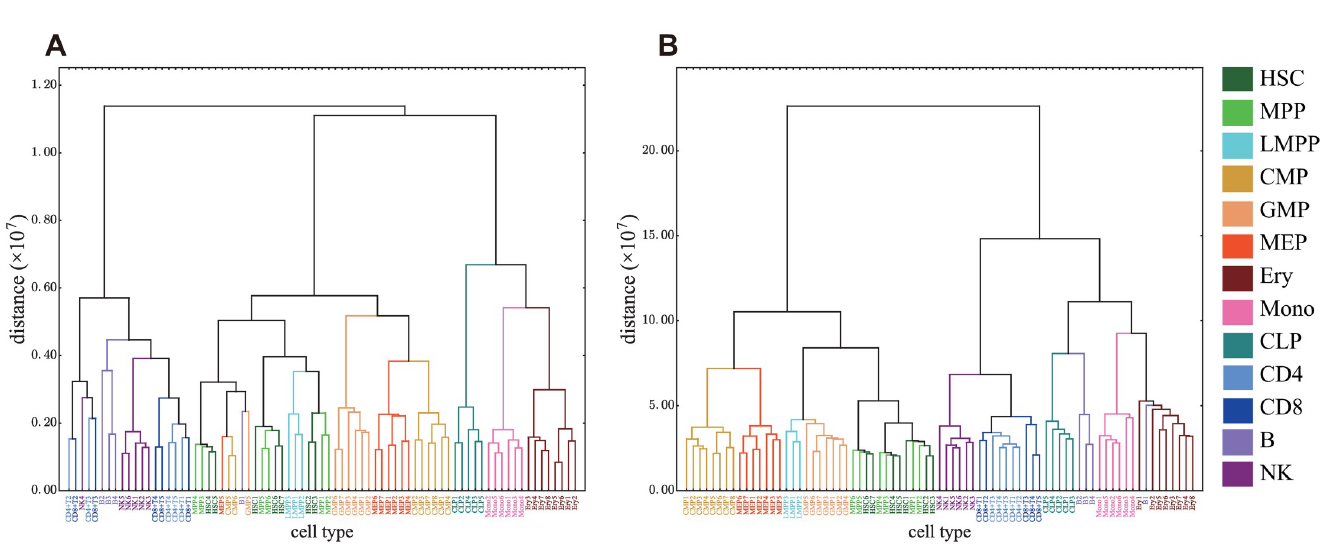
Fig 6. Examples of clustering dendrograms. Hierarchical clustering obtained by Ward’s method with parameters ( M cut , p